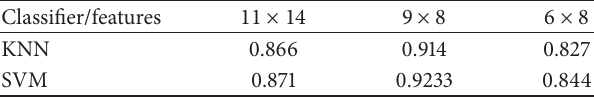
Table 2: Face recognition accuracy on Haar Wavelets.